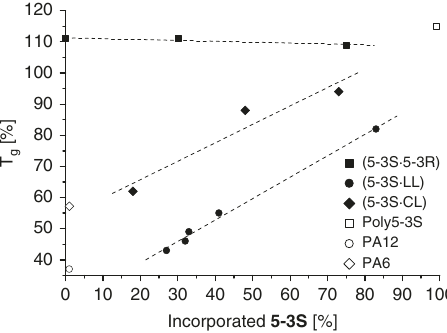
Fig. 7 Co-polymerization effects. In fl uence of the inclusion of 5-3S on the T g of co-polyamides with CL and LL (Supplementary Figs. 23 conditions: Supplementary Table 16).